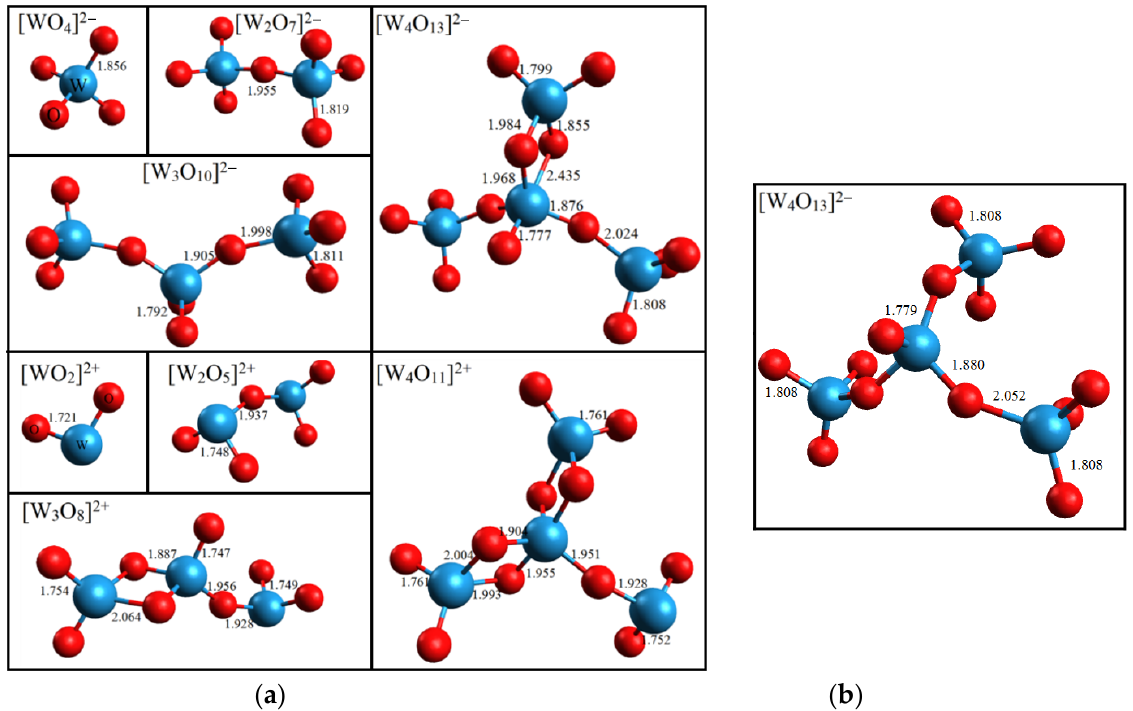
2– and W 2+ compounds after geometric optimiza- O O and W x O 2 + compounds after geometric optimiza- x 3x+1 x 3x–1 3x + 1 3x − 1